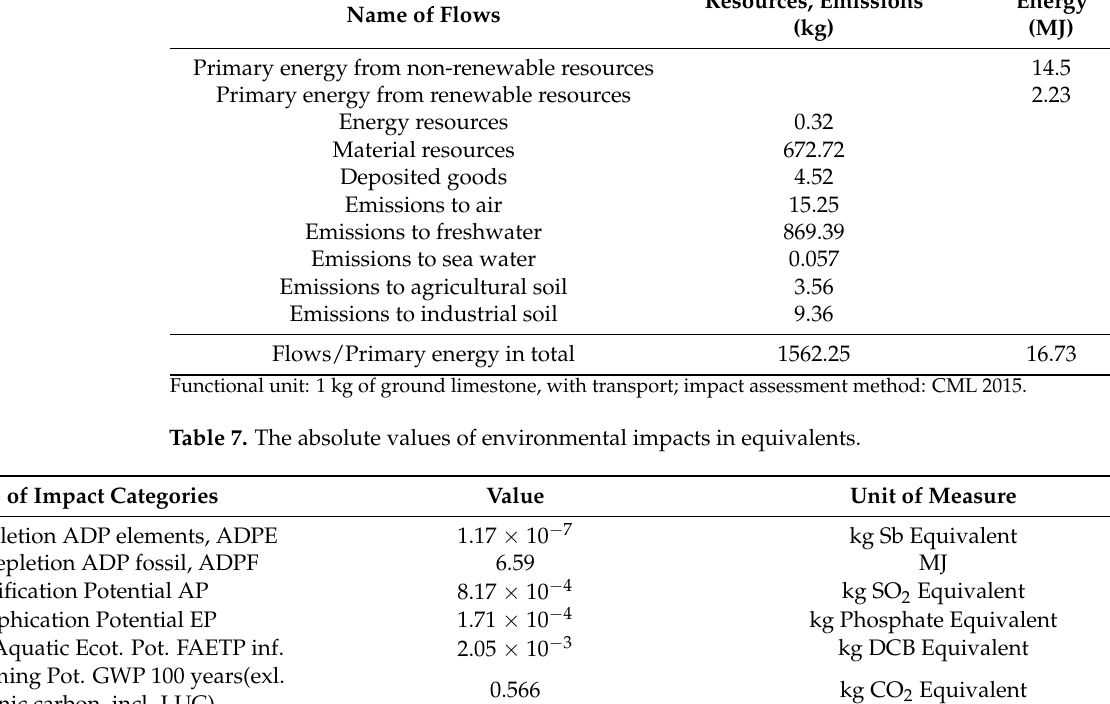
Table 7. The absolute values of environmental impacts in equivalents.